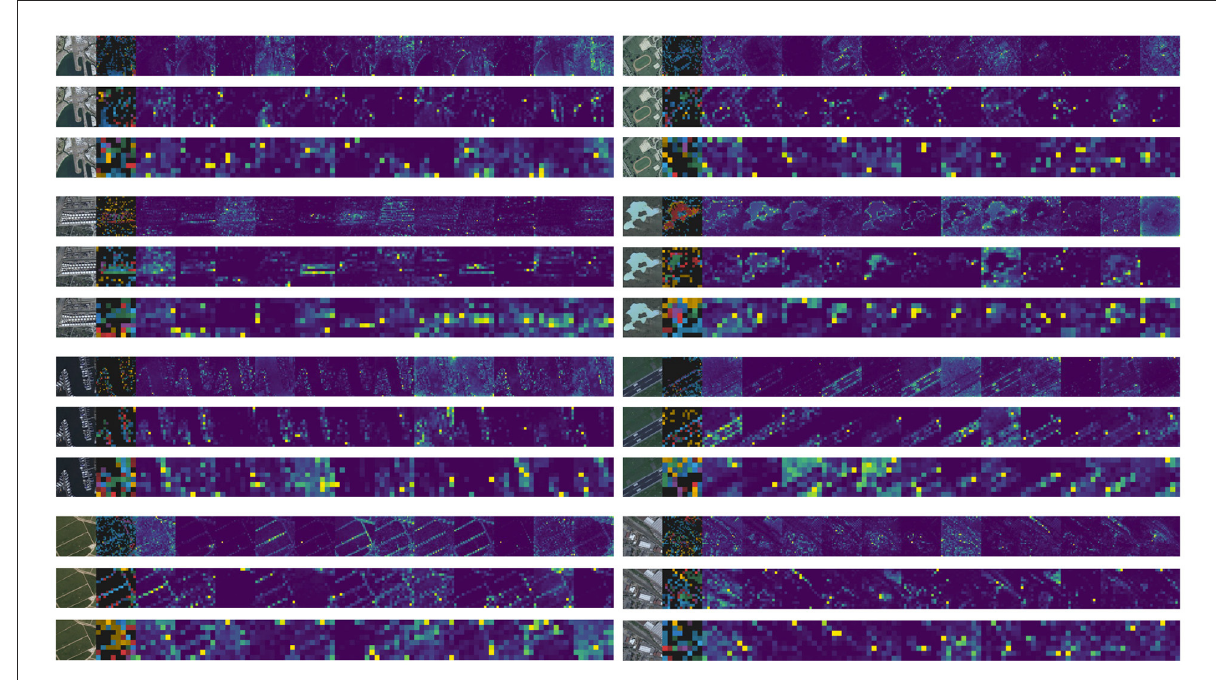
FIGURE6 Attention map visualization diagrams with patch size of 8 (top) , 16 (middle) , and 32 (bottom)